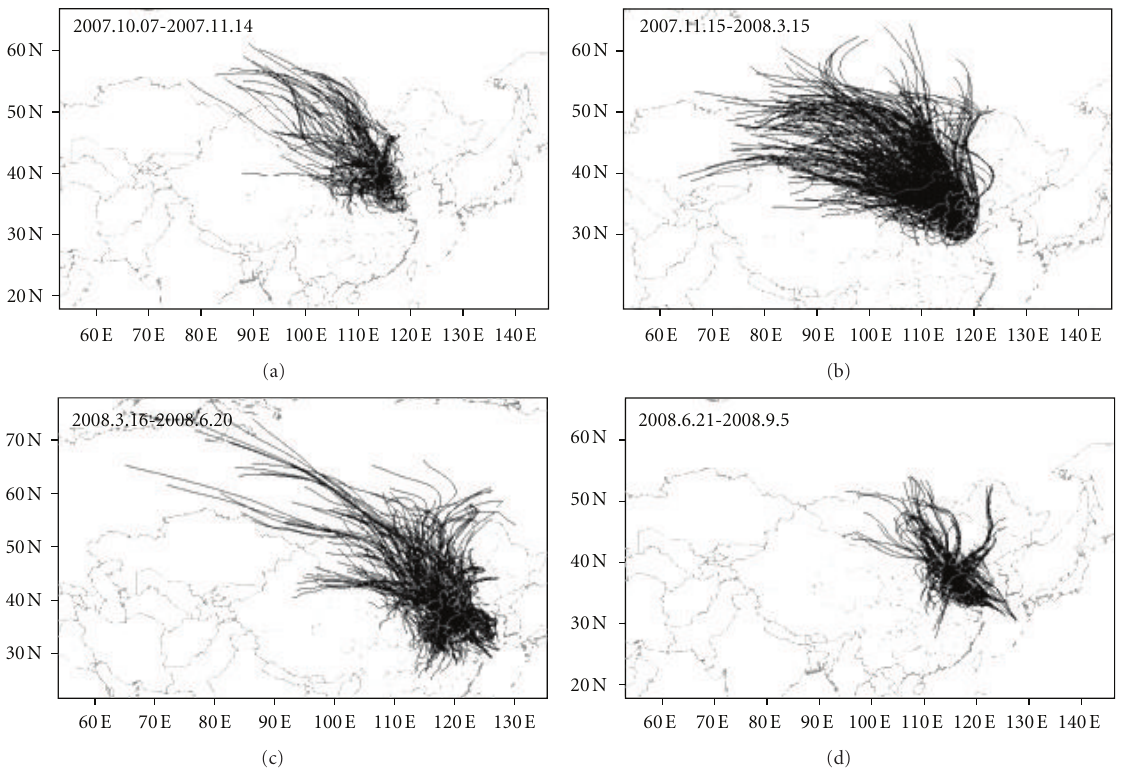
Figure 8: Backward trajectories to Lake Small Baiyangdian in four time.